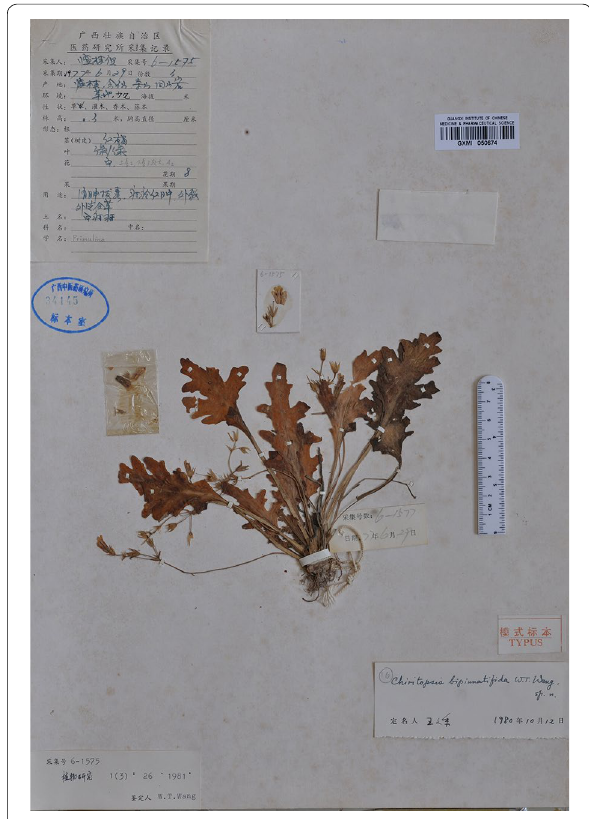
Fig. 6 Holotype of Chiritopsis bipinnatifida W.T.Wang [ Lingui Exped. 6 ‑ 1575